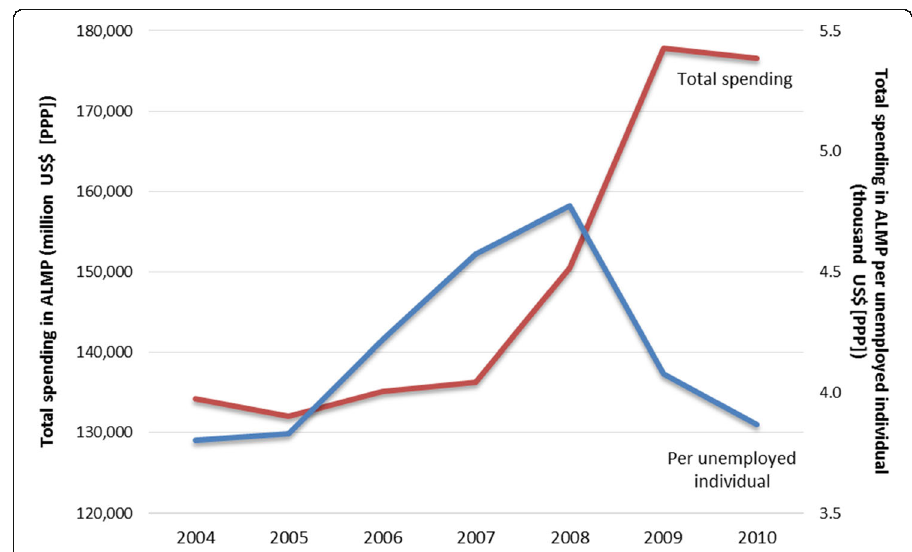
Fig. 1 Evolution of total expenditure on ALMPs, 2004 – 2010. Source: Author ’ s calculations based on